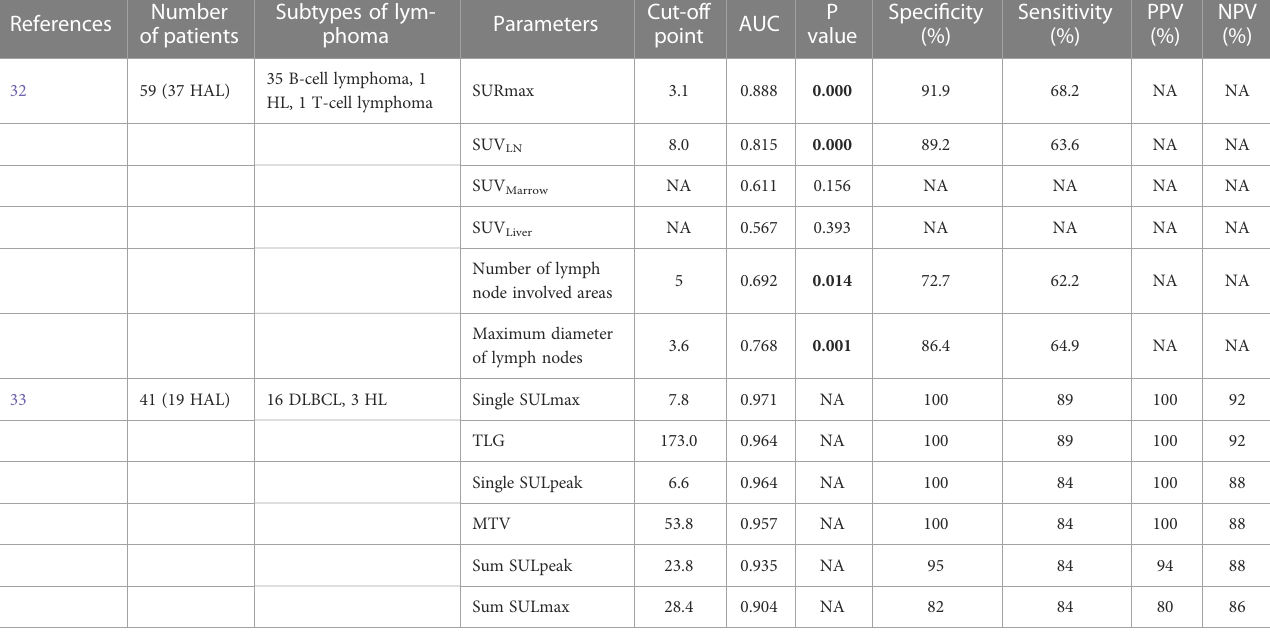
TABLE 1 The diagnostic ef fi cacies of FDG PET/CT in differentiating HIV-associated lymphoma from benign